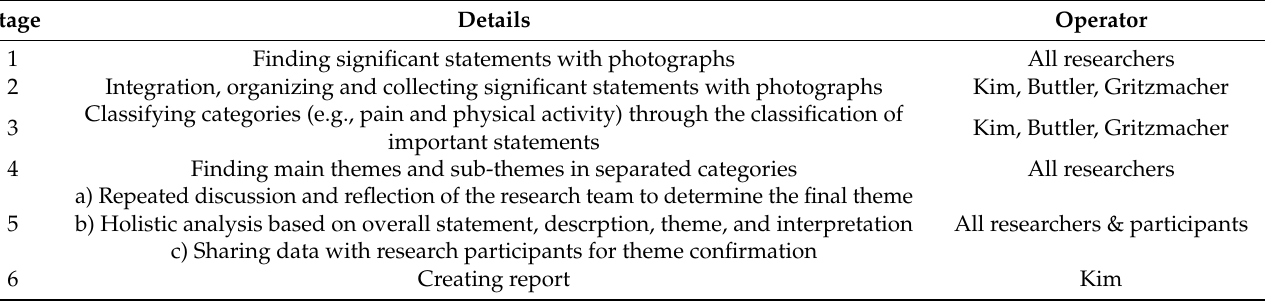
Table 2. Data analysis